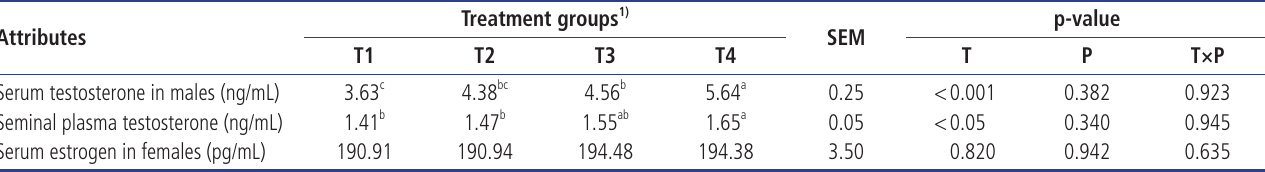
Treatment groups 1)